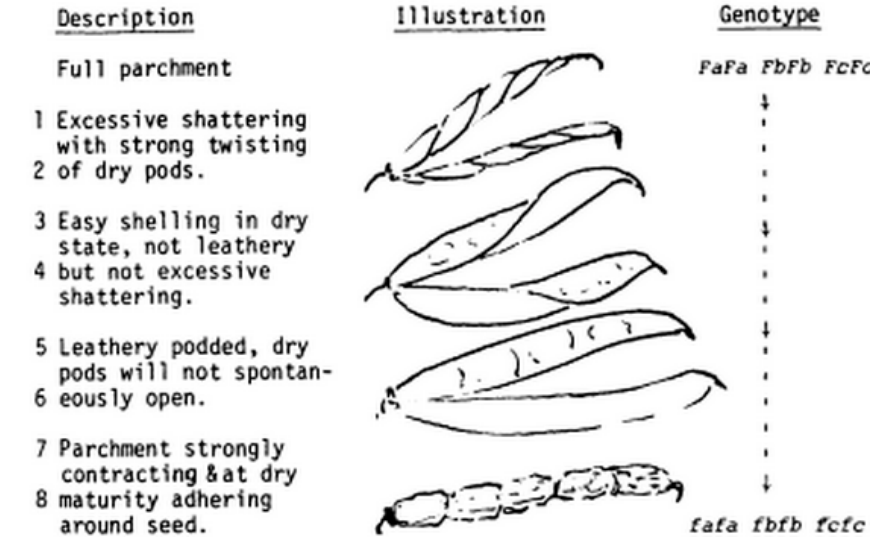
Figure 10. Illustration of the genetic model proposed by Lamprecht [46] for the modulation of fiber content in the pod valves and seed shattering in common bean. The model shows one major locus (FA) that controls the fiber content in the valves, with additional genes that have minor effects on the trait. Seed shattering and valve twisting are progressively reduced when recessive alleles are carried in these loci.